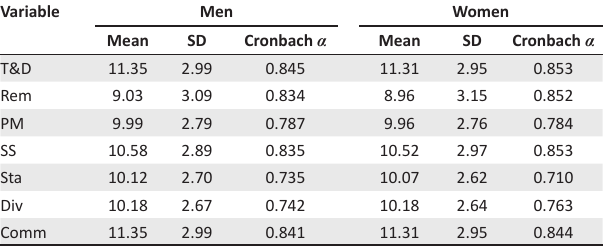
TABLE 4: Scale means, standard deviations and reliability coefficients on the Human Resource Practices Scale per gender.